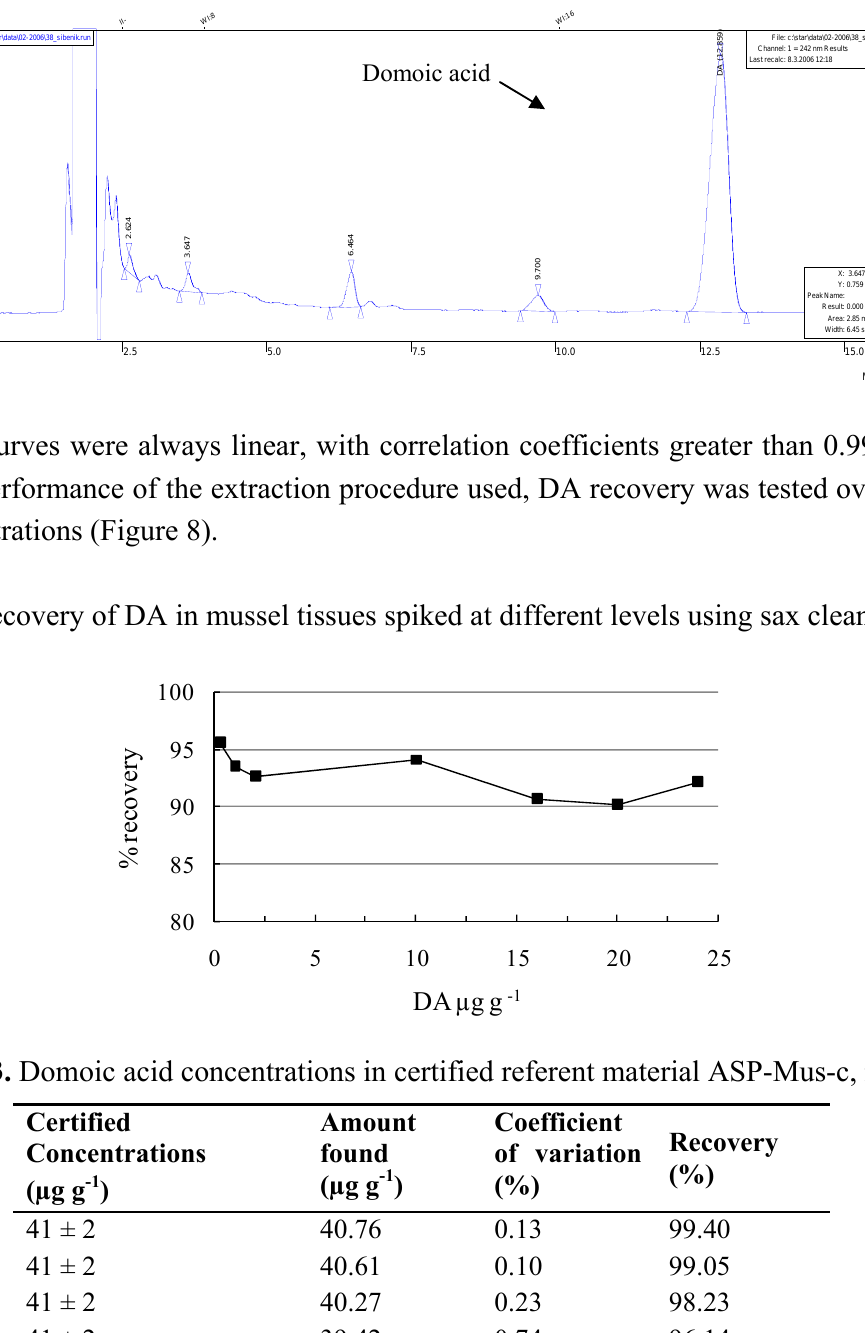
Figure 7. HPLC-UV chromatogram of contaminated mussel SAX-cleaned extract contains